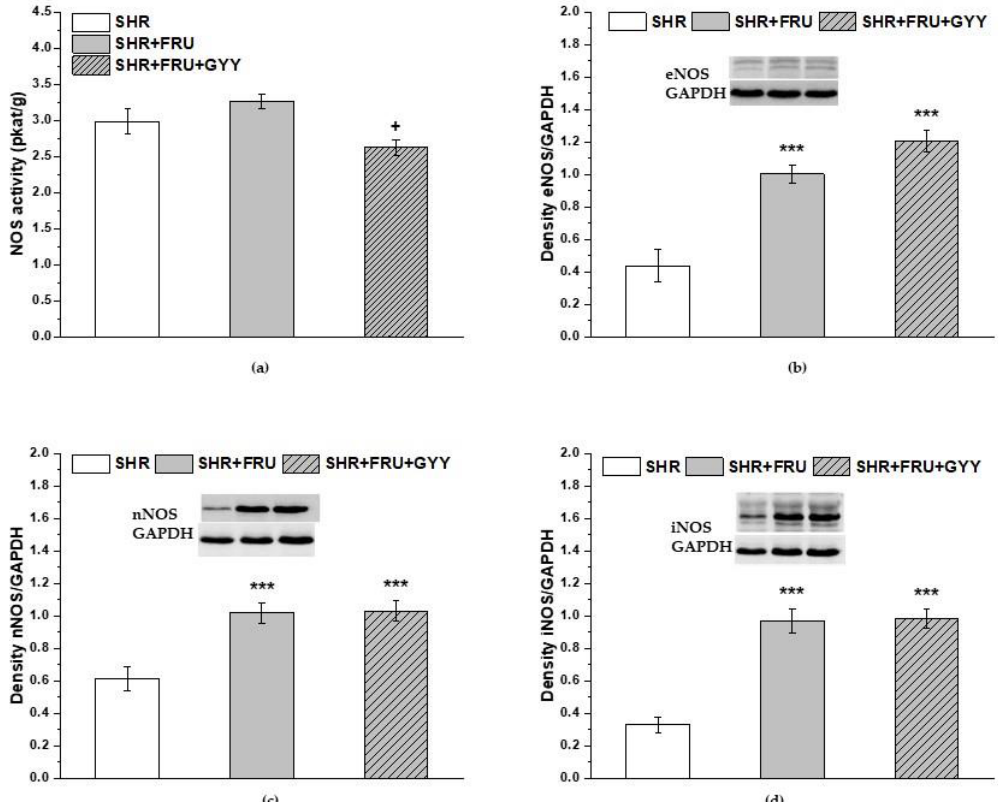
Figure 7. The total NOS activity ( a ), the protein levels of endothelial NOS ( b ), neuronal NOS ( c ), and inducible NOS ( d ) in the left ventricle. Spontaneously hypertensive rats (SHRs), SHRs treated with fructose (SHR+FRU), and SHRs treated with fructose and GYY-4137 (SHR+FRU+GYY). Endothelial NOS—eNOS; neuronal NOS—nNOS; inducible NOS—iNOS. Data are expressed as the mean ± S.E.M. Statistical analysis was performed by one-way ANOVA. *** p < 0.001 vs. SHR, + p < 0.05 vs.